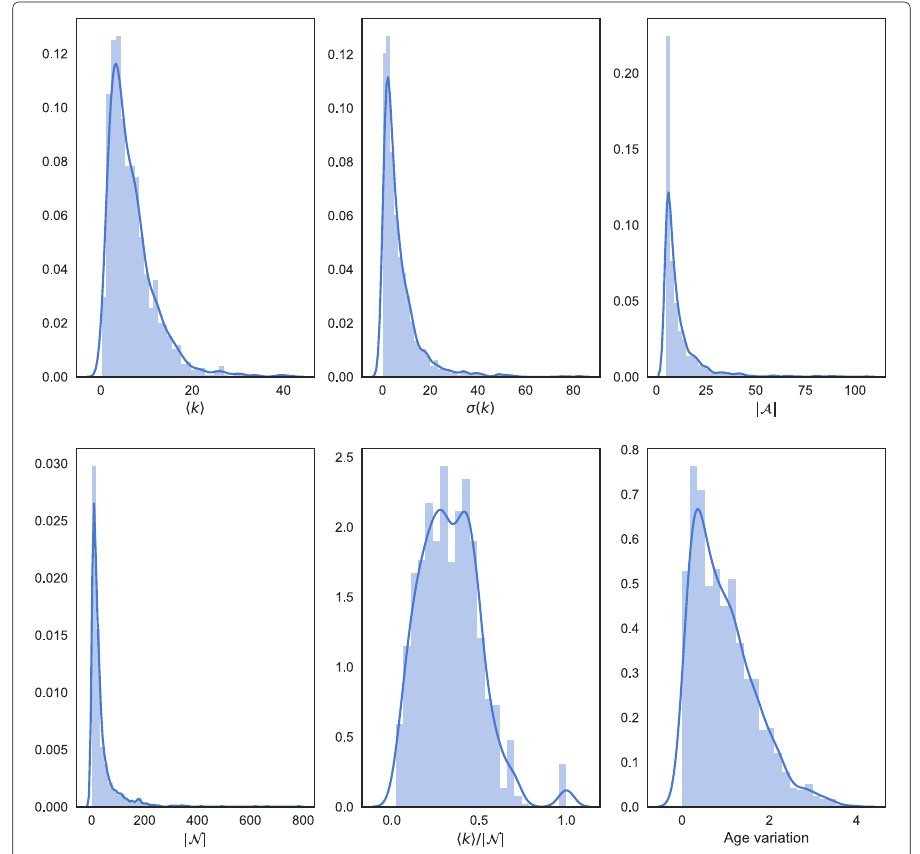
few antichain communities can have close to a 1,000 shared neighbours. The distribution of (cid:11) k (cid:12) peaks around 6 but there is often a sizeable variation in the degree as shown by similarly large values of σ( k )